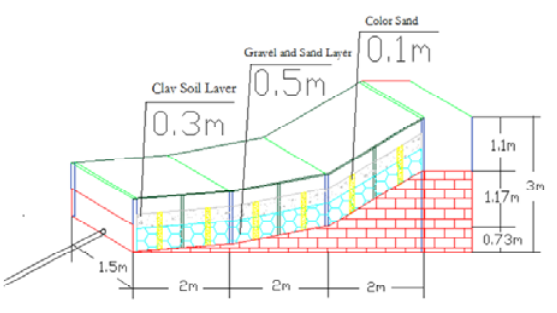
Figure 3. The layout of the simulated landslide platform The platform is built with red bricks as its foundation, and the tempered glass of 2cm width to contain the landslide